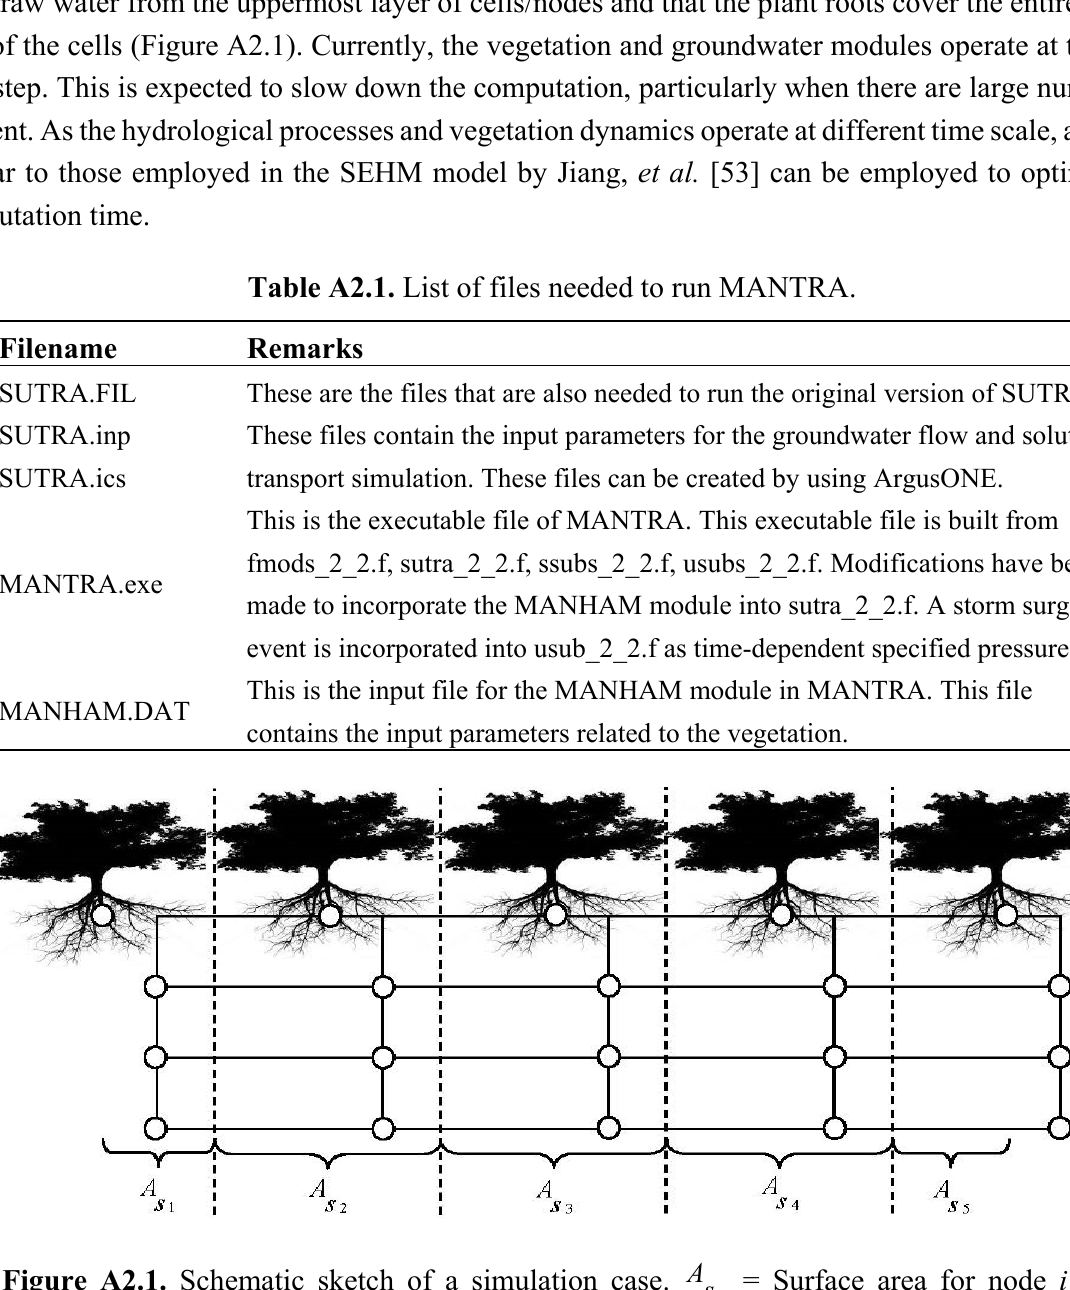
Figure A2.1. Schematic sketch of a simulation case. uppermost layer of